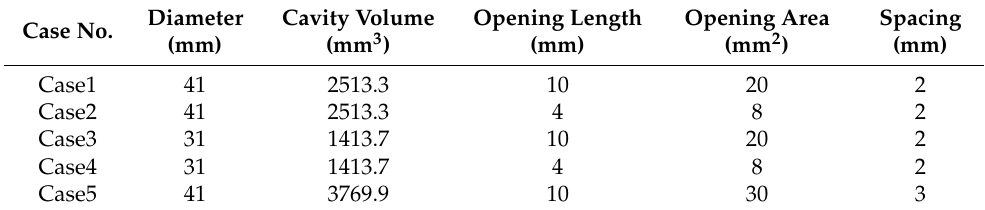
Figure 7. Schematic diagram of jet path. ( a ) Linear type ( b ) Flared type ( c ) Real PAJ. Table 1. Specifications of devices of piezo actuation jet.